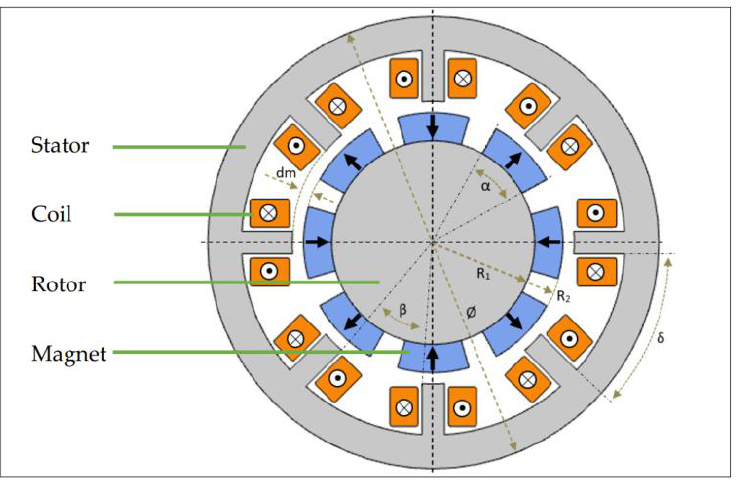
Figure 3. 2D cross-section of generator assembly.